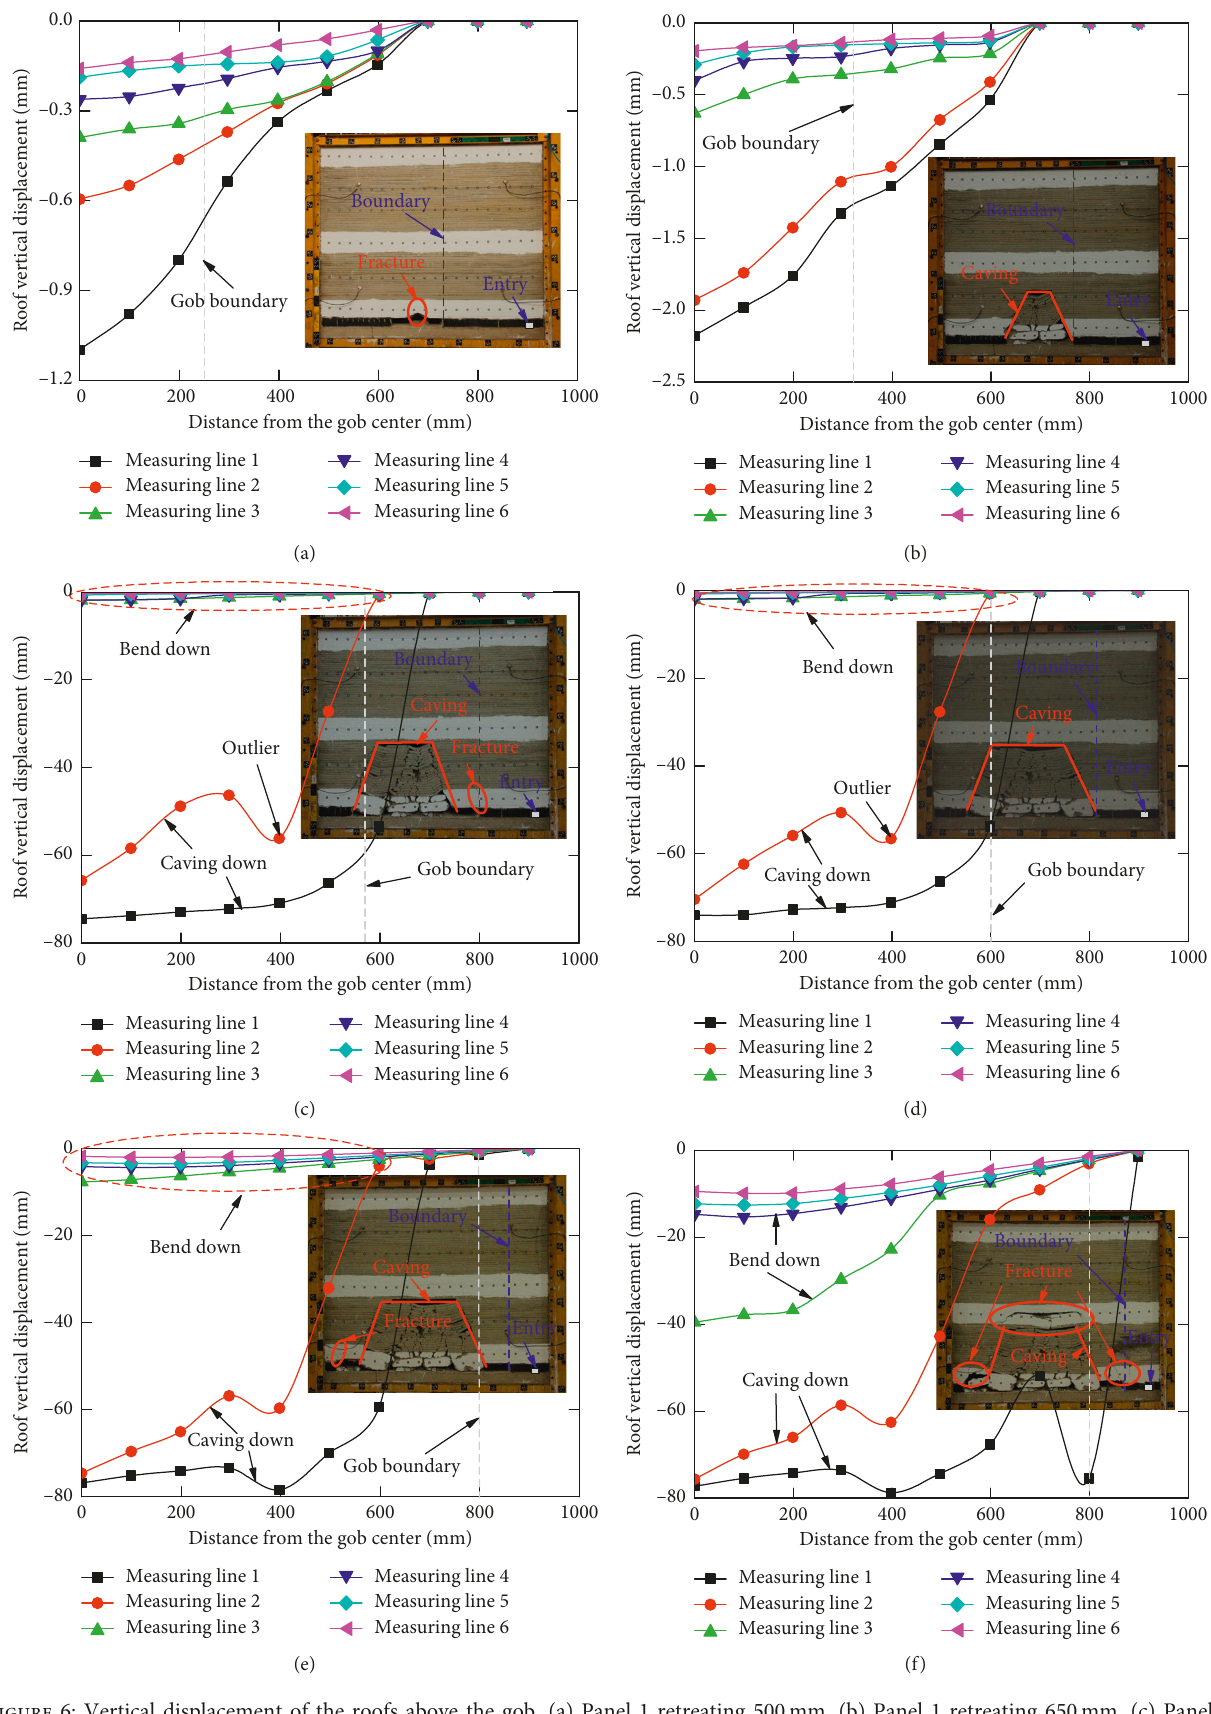
Figure 6: Vertical displacement of the roofs above the gob. (a) Panel 1 retreating 500mm. (b) Panel 1 retreating 650mm. (c) Panel 1 retreating 1150mm. (d) Panel 1 retreating 1200mm. (e) Panel 1 retreating 1600mm. (f) Applying additional abutment